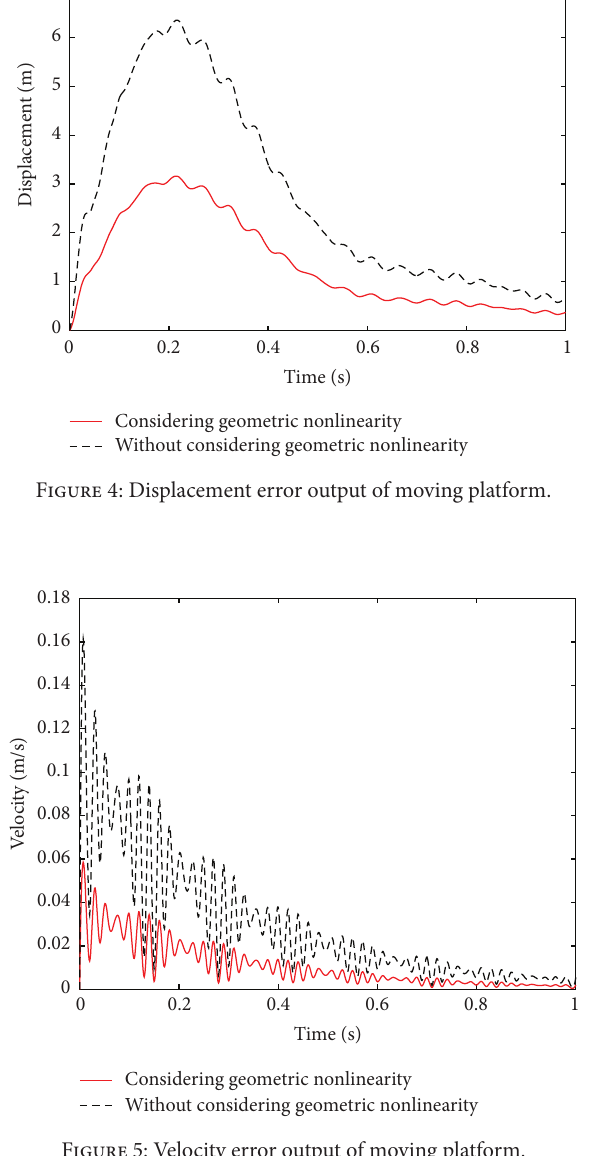
Figure 5: Velocity error output of moving platform.